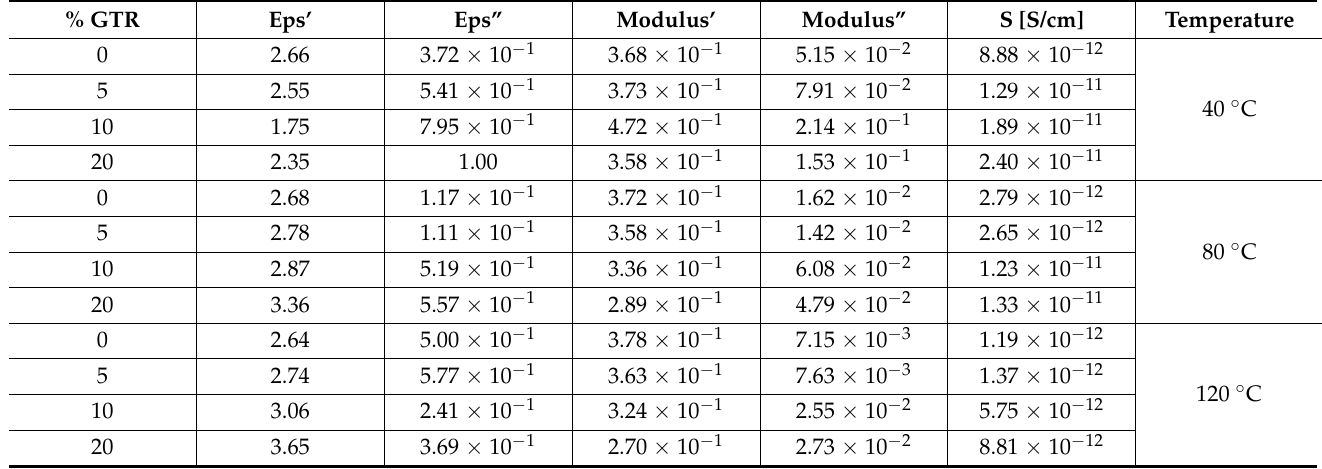
Table 4. Evolution of real modulus; imaginary modulus; real permittivity; imaginary permittivity and conductivity (S/cm), for EPDM composites with GTR growing amounts, at 50 Hz and 40, 80 and 120 ◦